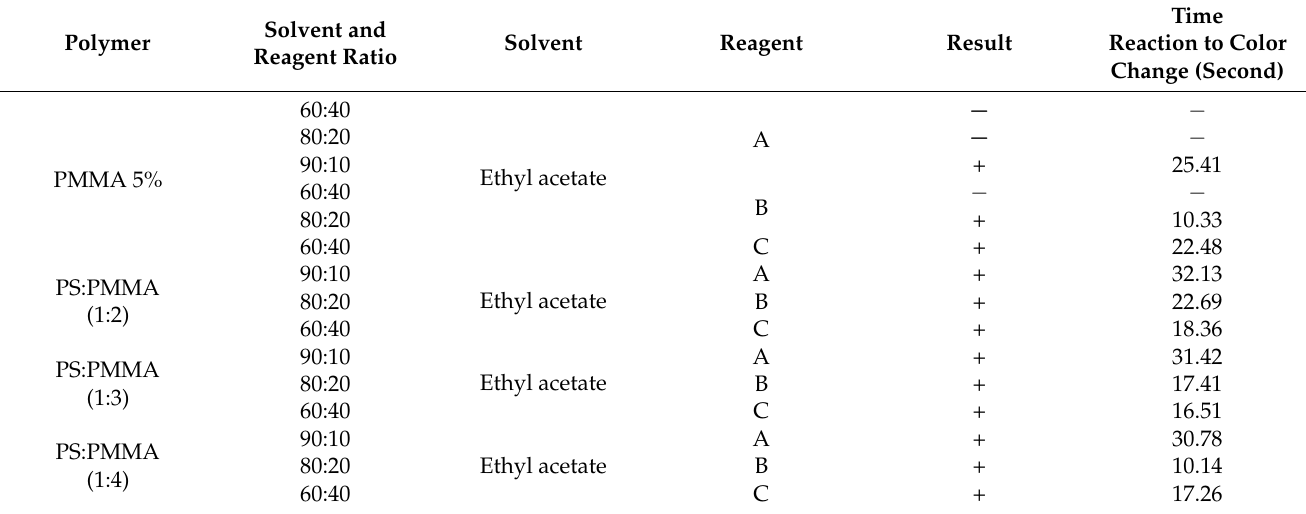
Table 2. Result of developing indicator strips from the PMMA and PS:PMMA mixture using a reagent blending